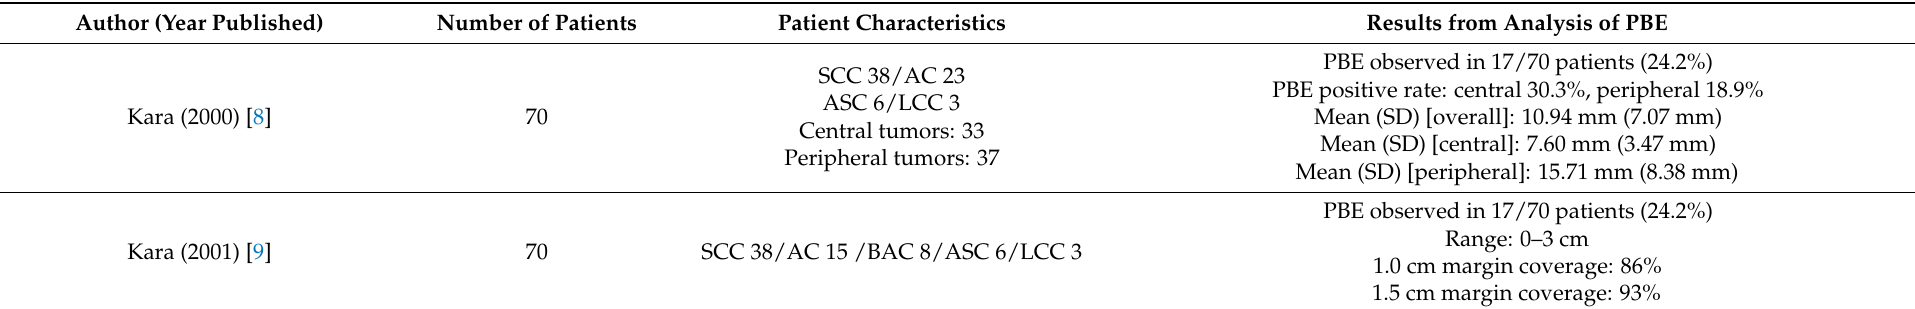
Table 2. Studies reporting microscopic